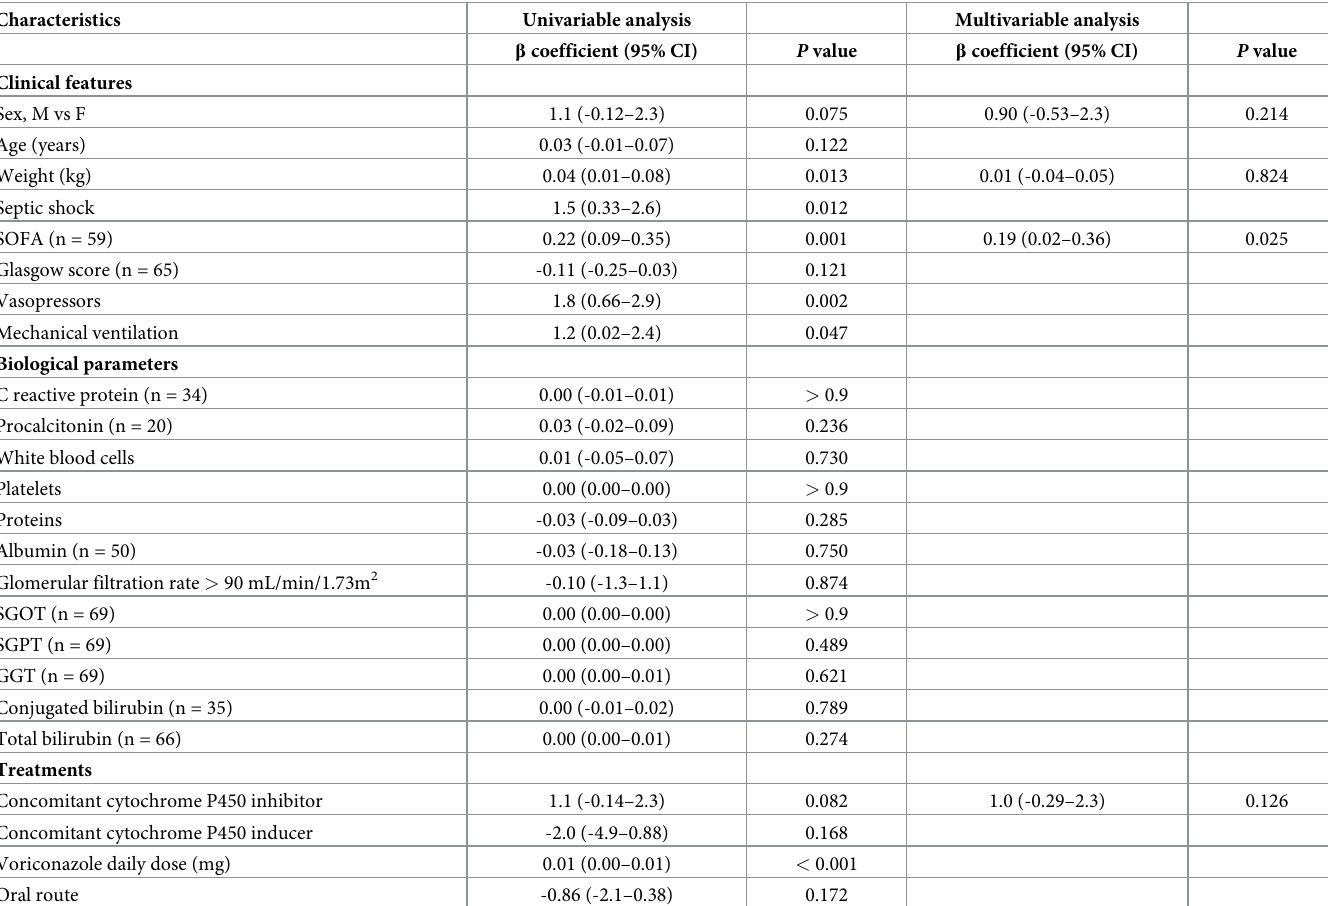
Table 2. Univariable and multivariable analyses of variables potentially associated with voriconazole trough concentration. Data presented are β coefficients (95% CI) and their corresponding P values.